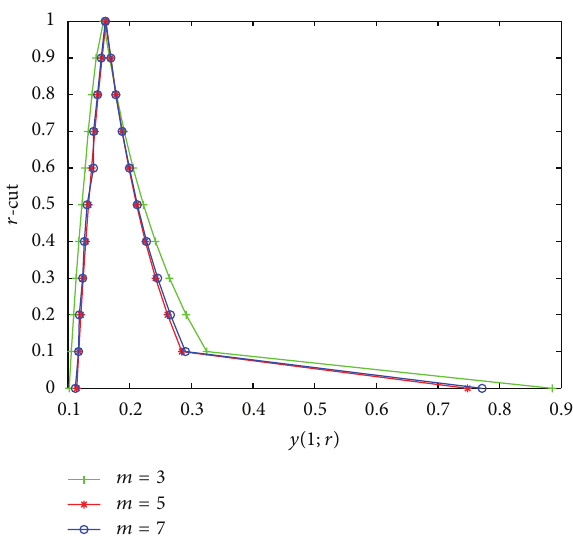
Figure 20: The approximate solution for different 𝑚 of Example 64, 𝛼 = 0.75 .